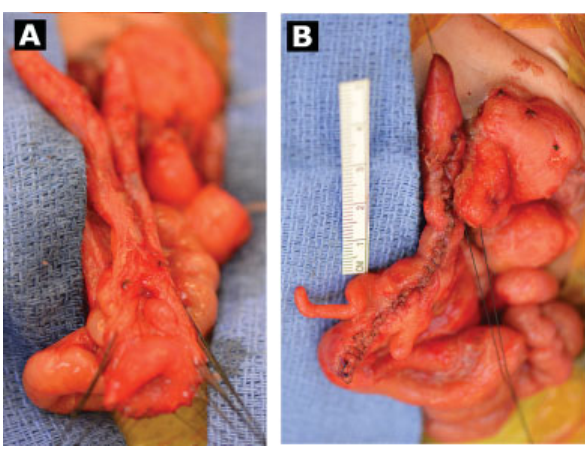
Fig. 3 Duplicated hindgut. ( A ) Before and ( B ) after uni fi cation. One hindgut segment was slightly longer than the other resulting in asymmetry of the uni fi ed segment.